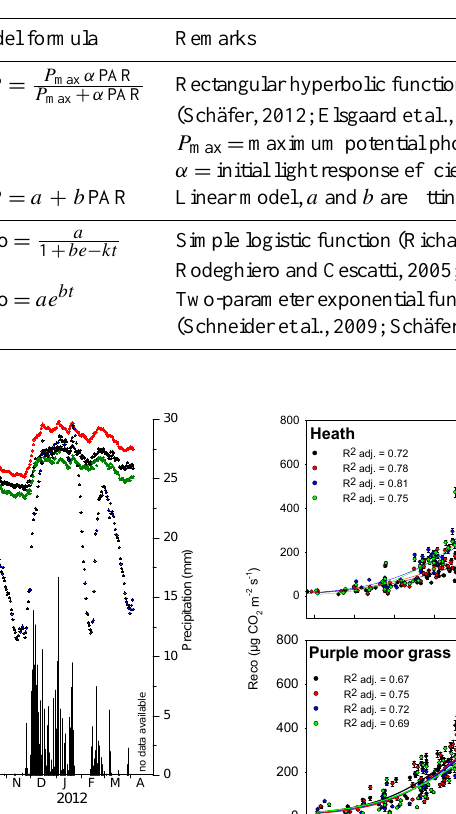
Table 1. Two model approaches for gross primary production (GPP) as a function of photosynthetically active radiance (PAR) and two temperature-driven ecosystem respiration (Reco) models, where t = air or soil temperature, respectively, and a , b and c are fitting parameters.